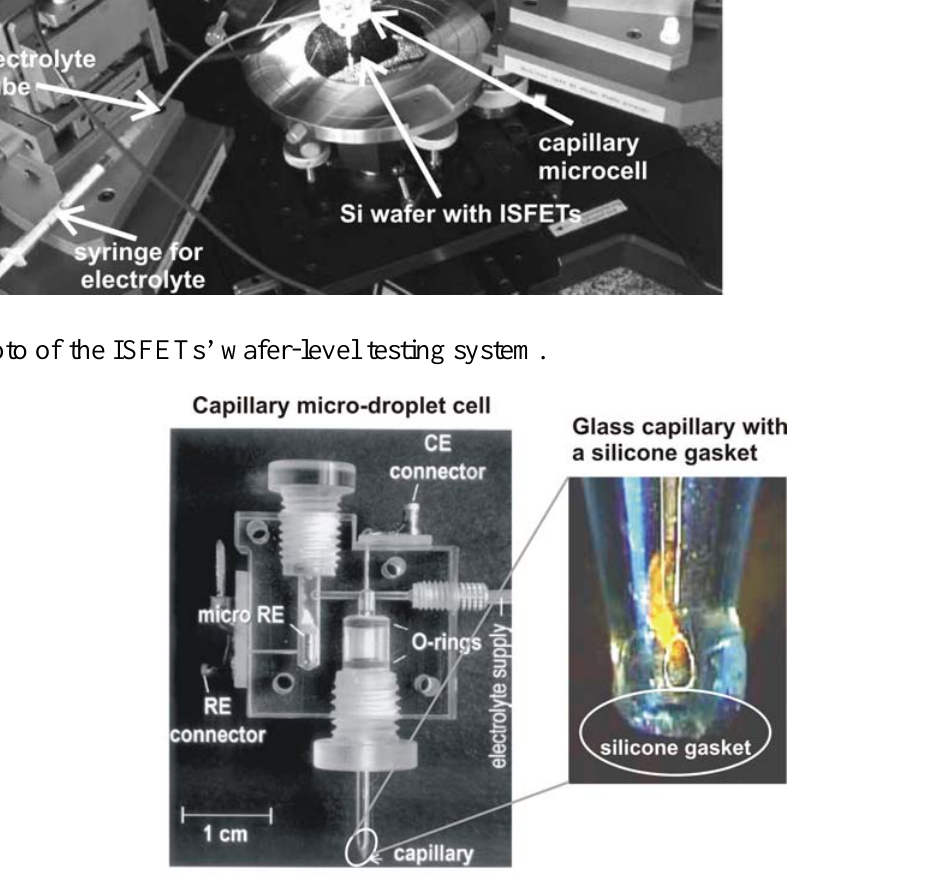
Figure 4. Capillary micro-droplet cell for testing of ISFETs on wafer level (RE: reference electrode, CE: counter